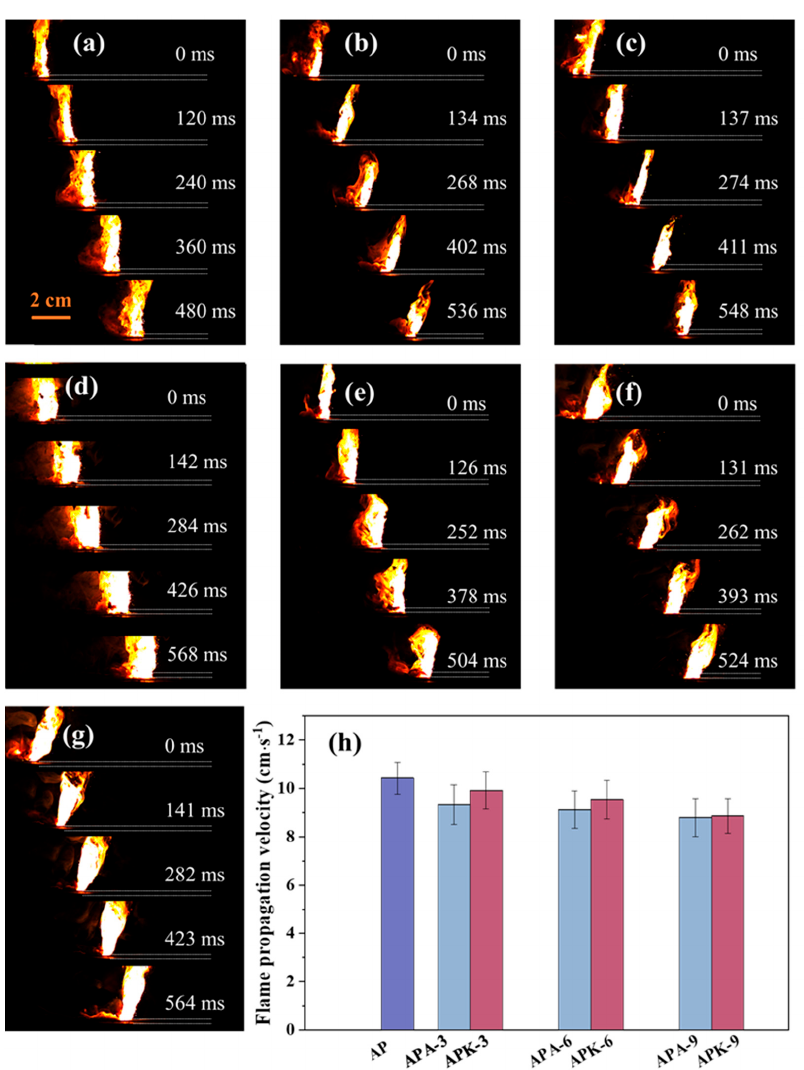
Figure 4. Flame propagation velocity of each sample under open conditions: ( a ) AP, ( b ) APA ‐ 3, ( c ) APA ‐ 6, ( d ) APA ‐ 9, ( e ) APK ‐ 3, ( f ) APA ‐ 6, ( g ) APA ‐ 9. ( h ) Average flame propagation velocity of each sample.